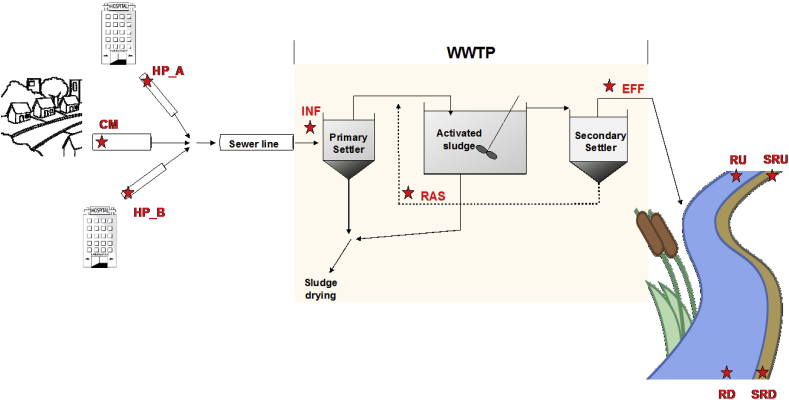
Study area and sampling sites. Label definitions as follows: CM = community wastewater, HP = hospital wastewater (HP_A and HP_B), INF = WWTP influent, RAS = recycled activated sludge, EFF = WWTP liquid effluent, RD = downstream river water column, RU = upstream river water column, SRD = sediment river downstream, and SRU = sediment river upstream.